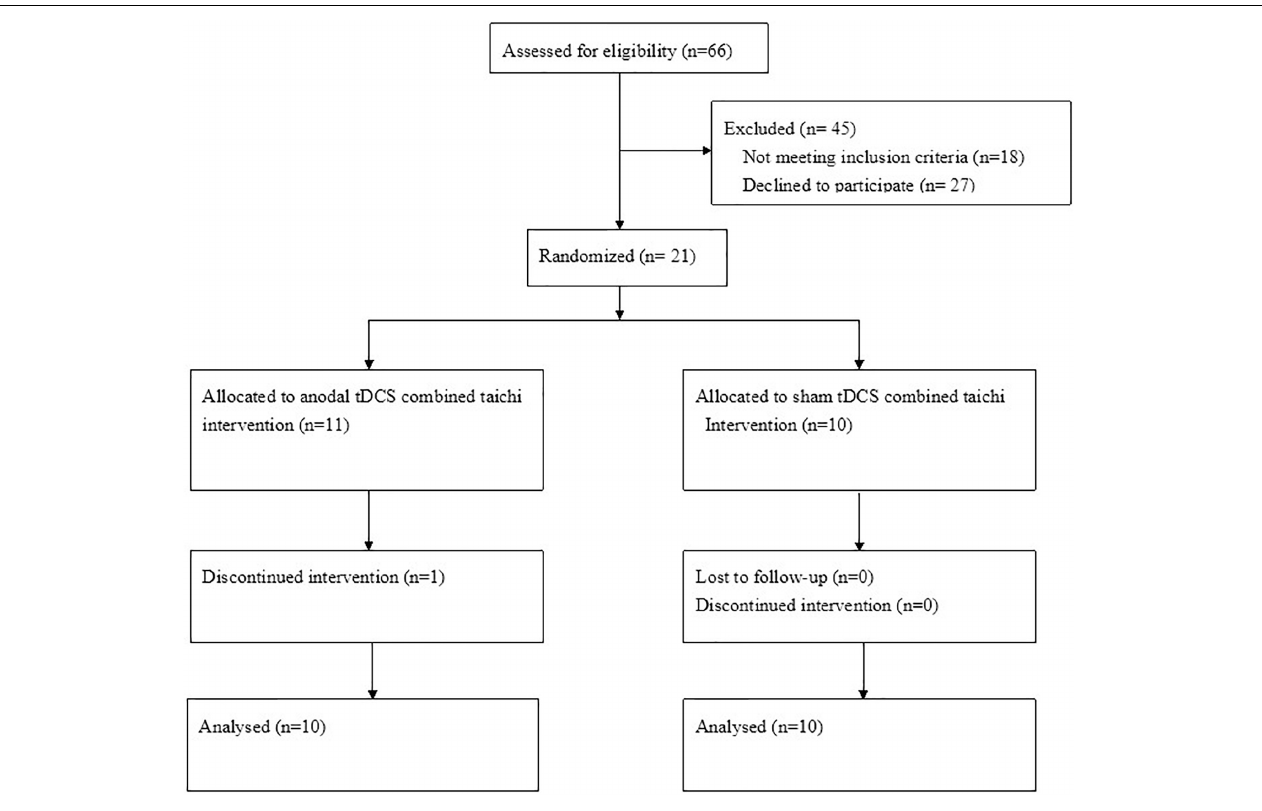
FIGURE 1 | Flow chart of the study design.